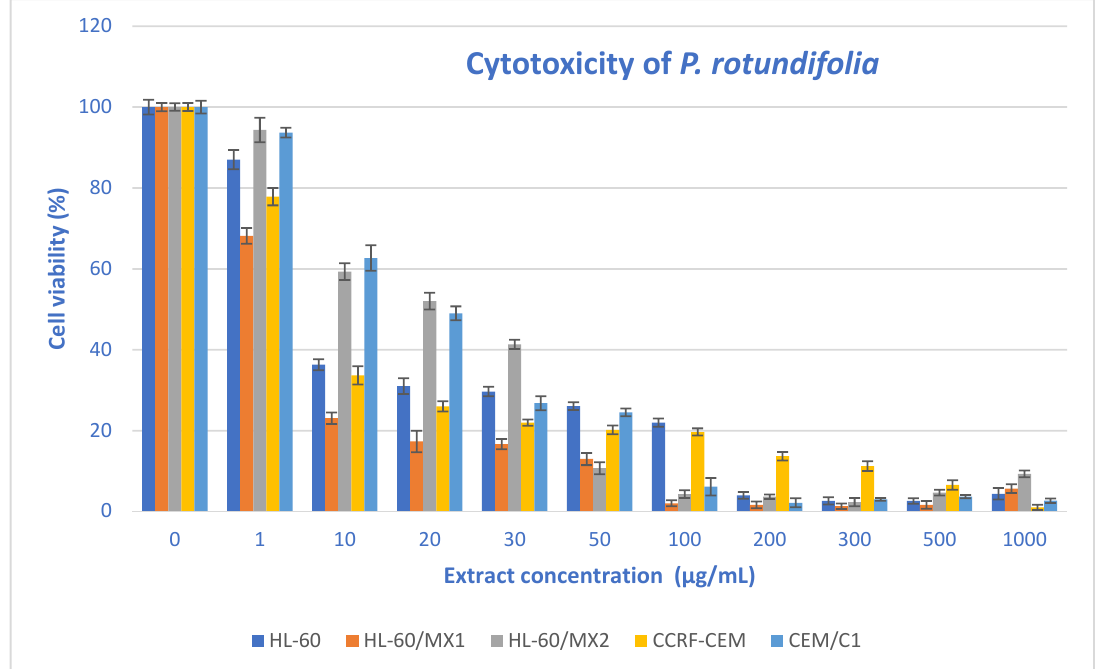
Figure 2. The valuation of the viability of various cell lines exposed to 24 h of increasing concentrations of an extract from P. rotundifolia leaves.